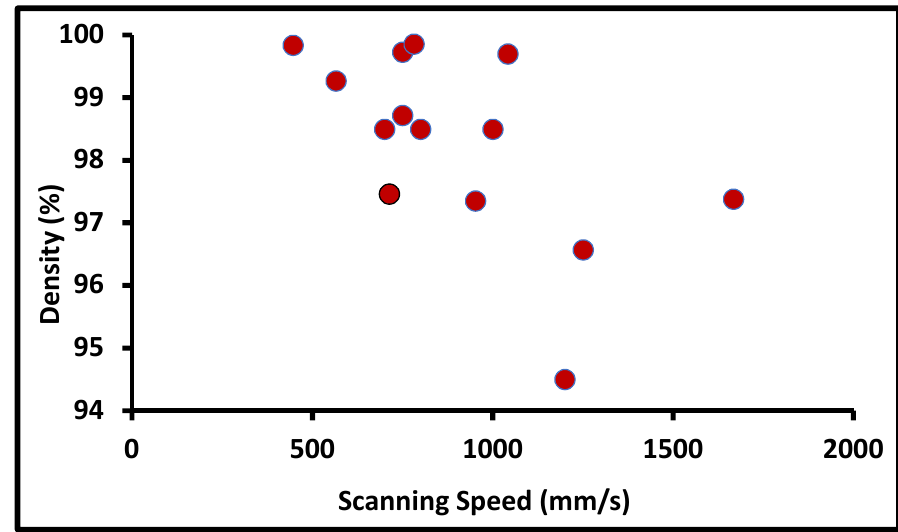
Figure 13. Density at a different scanning speed.